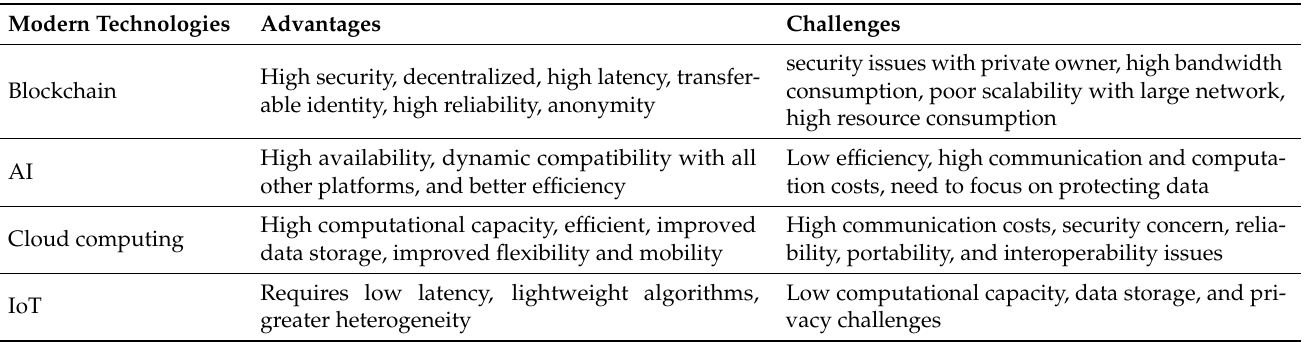
Figure 2. Emerging technologies and framework of smart healthcare systems with their essen- tial characteristics. Table 2. Comparison analysis of various services offered by modern